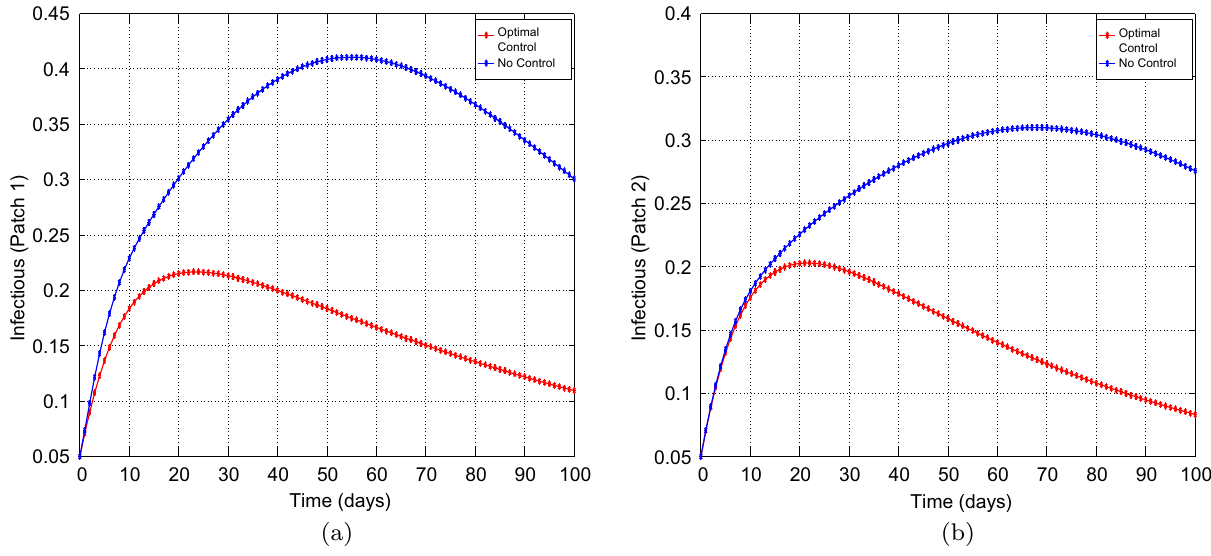
Figure 8. Simulation outcomes of the presented two patch COVID-19 mathematical model for case 2 under symmetric strong coupling ( a ) the number of infected humans in patch 1 ( b ) the number of infected humans in patch 2. In both figures, the red curves and blue curves represent the infected population, with optimal control and no optimal control respectively.